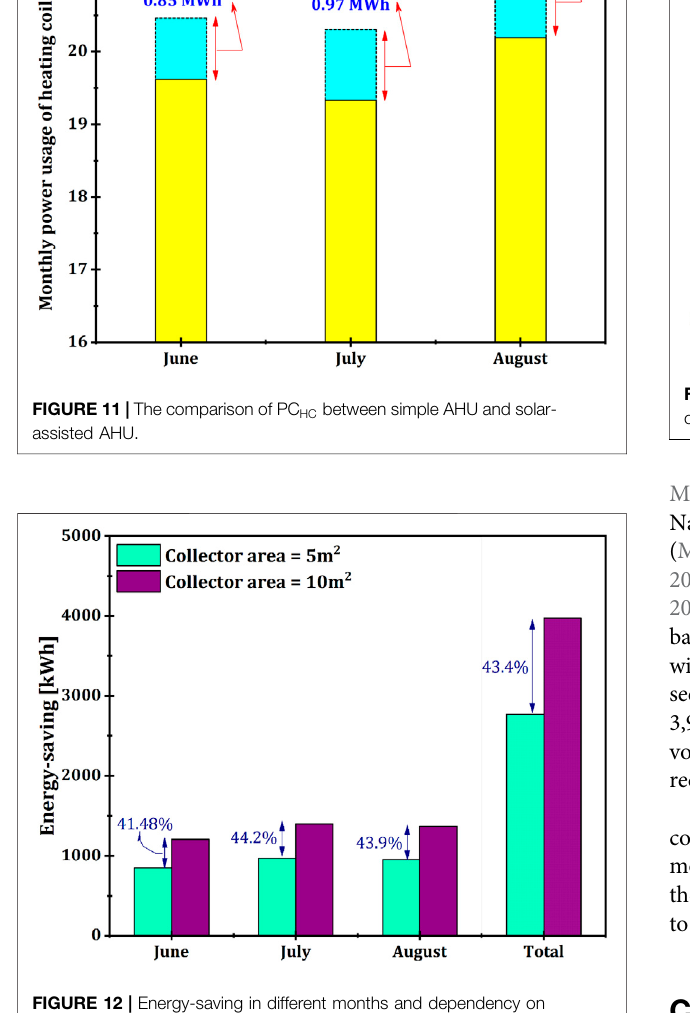
FIGURE 12 | Energy-saving in different months and dependency on collector area.